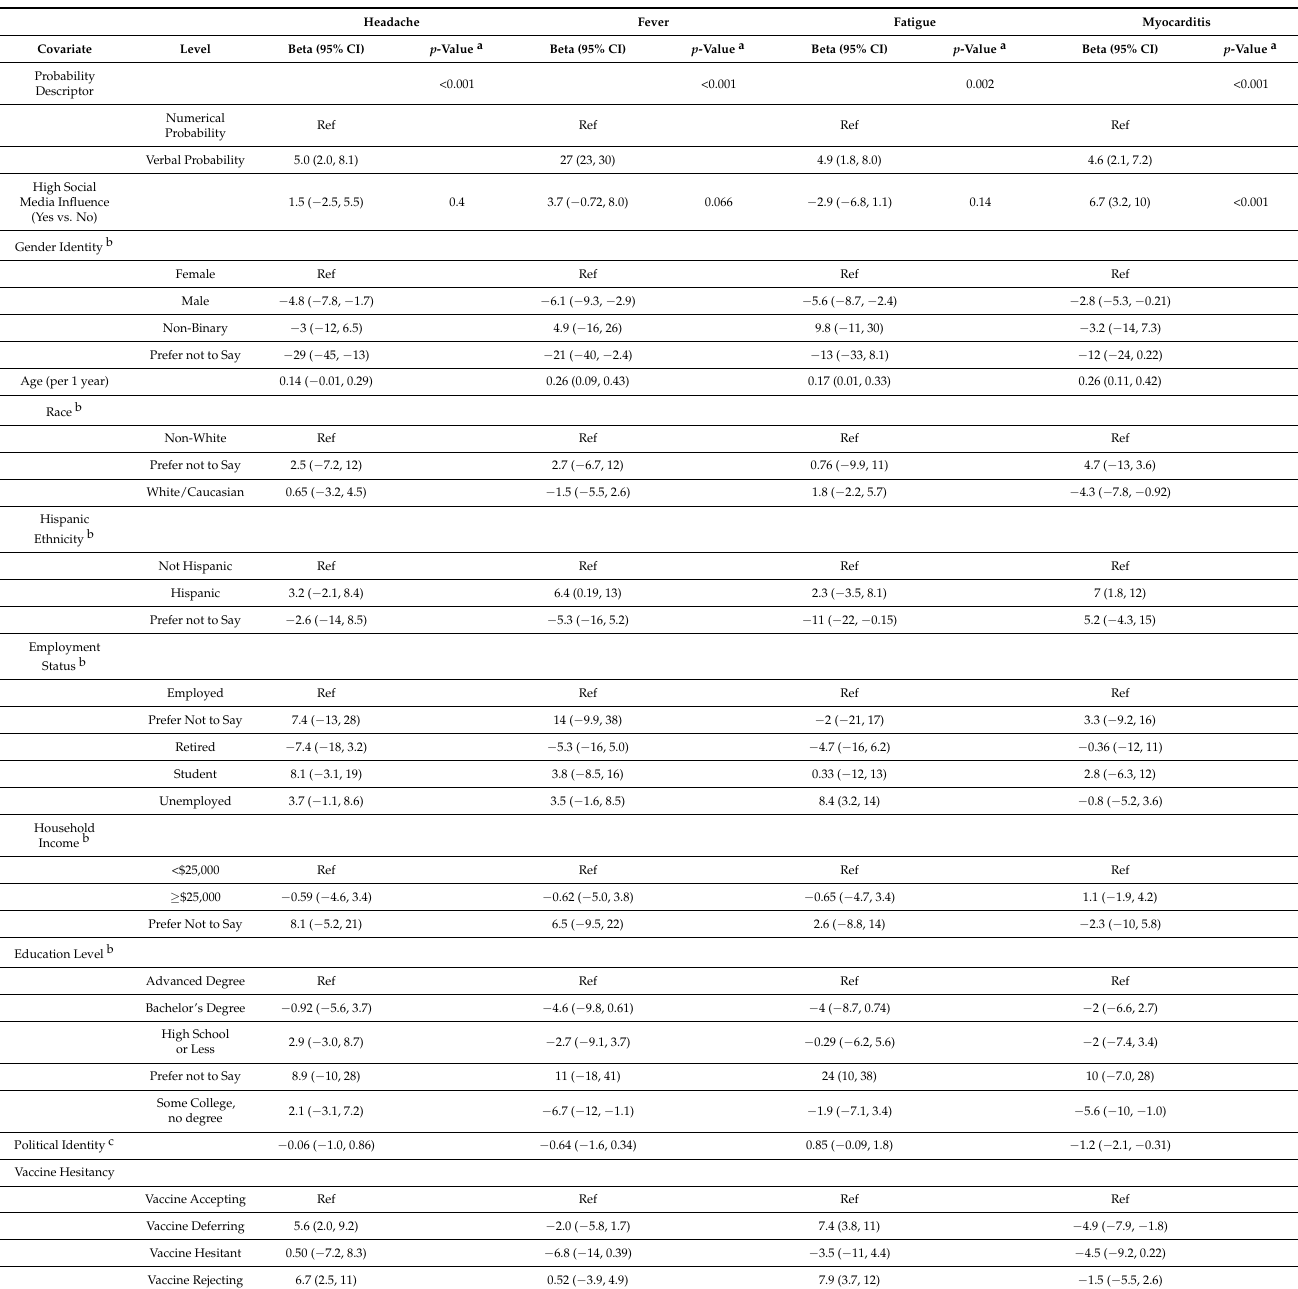
Table 2. Results of multivariable linear regression models of the perceived risk of COVID-19 vaccine side